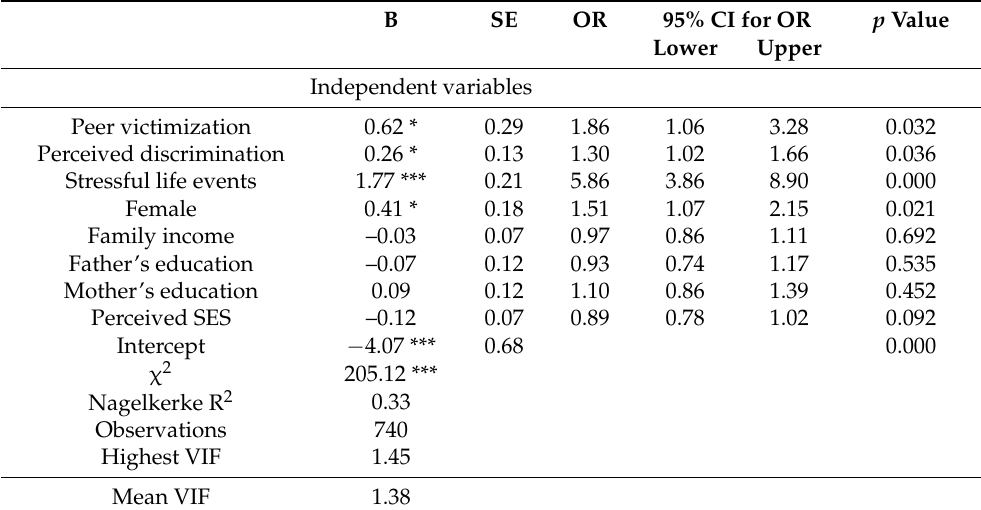
Table 2. Logistic regression estimates (risk factors) of depressive symptoms among LBC. B SE OR 95% CI for OR p